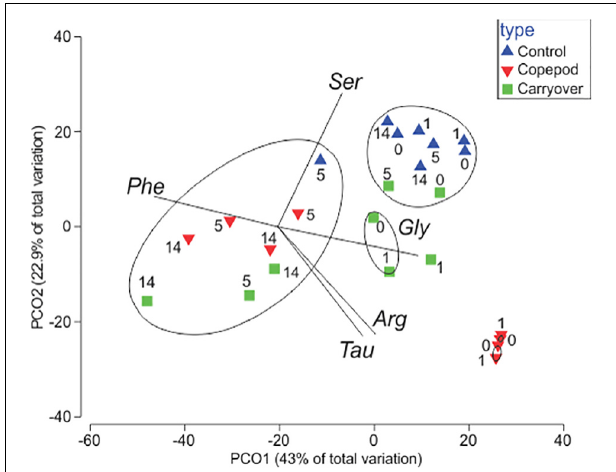
FIGURE 4 | Principal coordinates analysis assessing the change in Mol% of DFAA + Tau in the remineralization experiments over the duration of experiment (numbers represent days of incubation). SIMPROF analysis suggests five clusters ( p < 0.05; black circles). A Pearson correlation indicates which DFAAs [phenylalanine (Phe), serine (Ser), glycine (Gly), arginine (Arg), and taurine (Tau)] contributed to observed patterns in clustering (denoted as vectors; R >